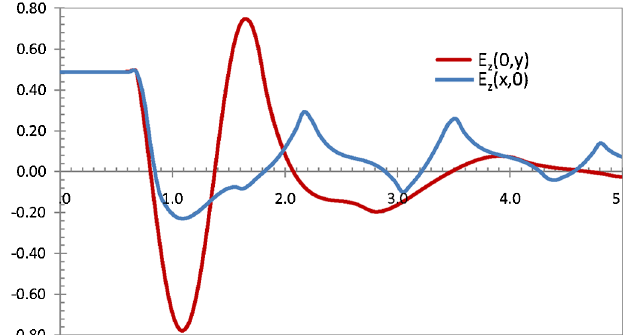
FIG. 13. Lineout plot of the TM mode longitudinal field (arbitrary units) calculated with the multipole method along the two transverse dimensions (in microns) for the 4 : 9 (cid:3) m fiber when scaled to a 1 : 3 (cid:3) m lattice